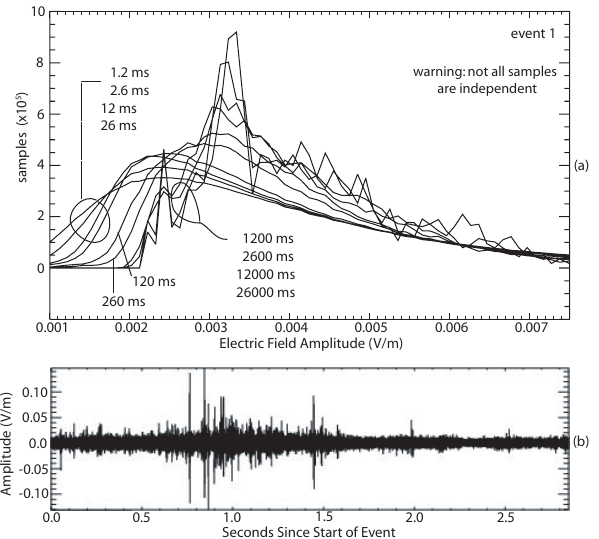
(b) Time series of the sampled electric field amplitudes in event 2, corrected for the automatic gain control and decimated by a factor of 100.